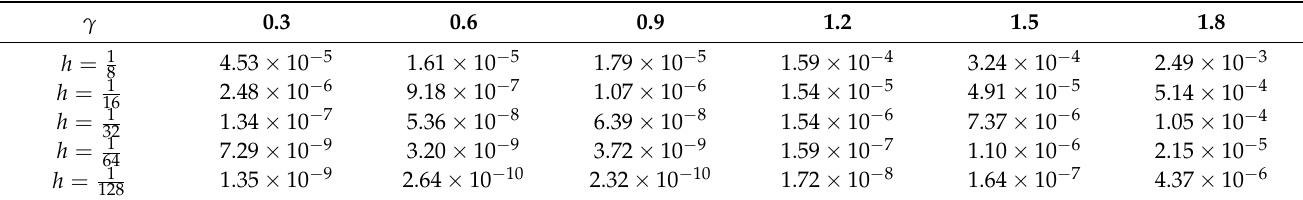
Table 2. Example 2: The infinity norm of the error (cid:107) e h (cid:107) for different values of γ and h . γ